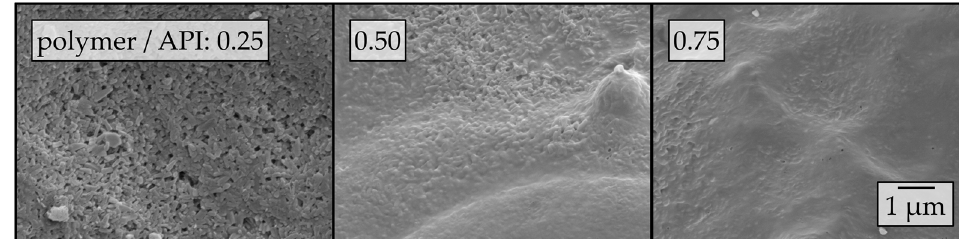
Figure 8. Surface morphologies of granules produced by applying naproxen nanosuspensions with different amounts of additional polymer (i.e., PVP/VA) to lactose carrier particles in a fluidized granulation process, assessed by SEM.